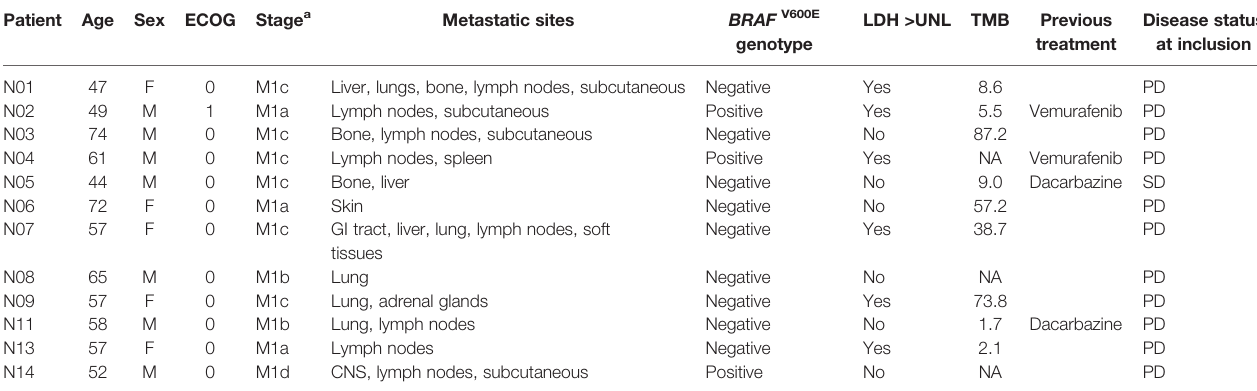
TABLE 1 | Patient baseline